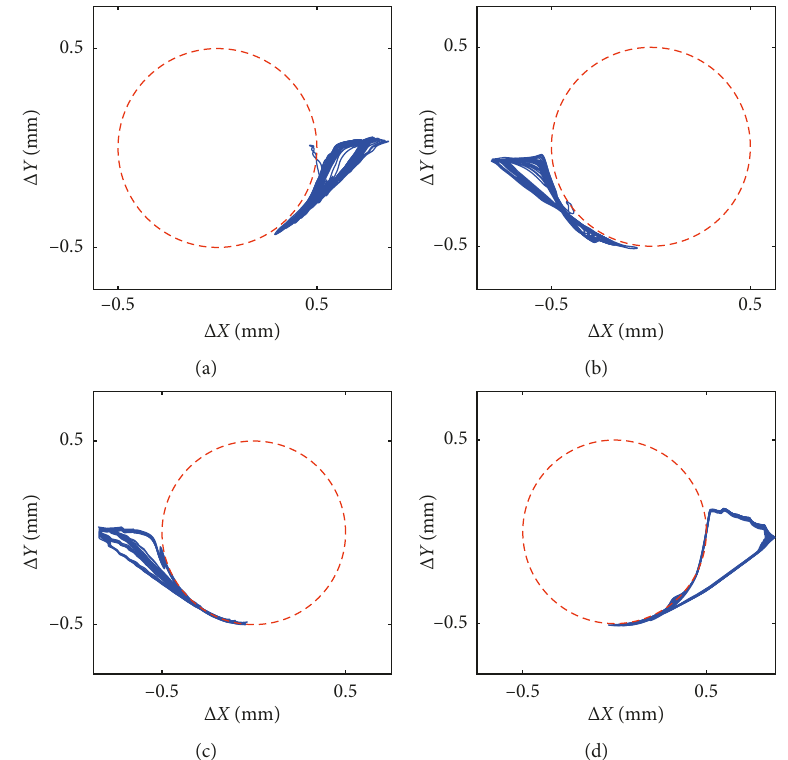
Figure 12: Trajectories in clearance joints P